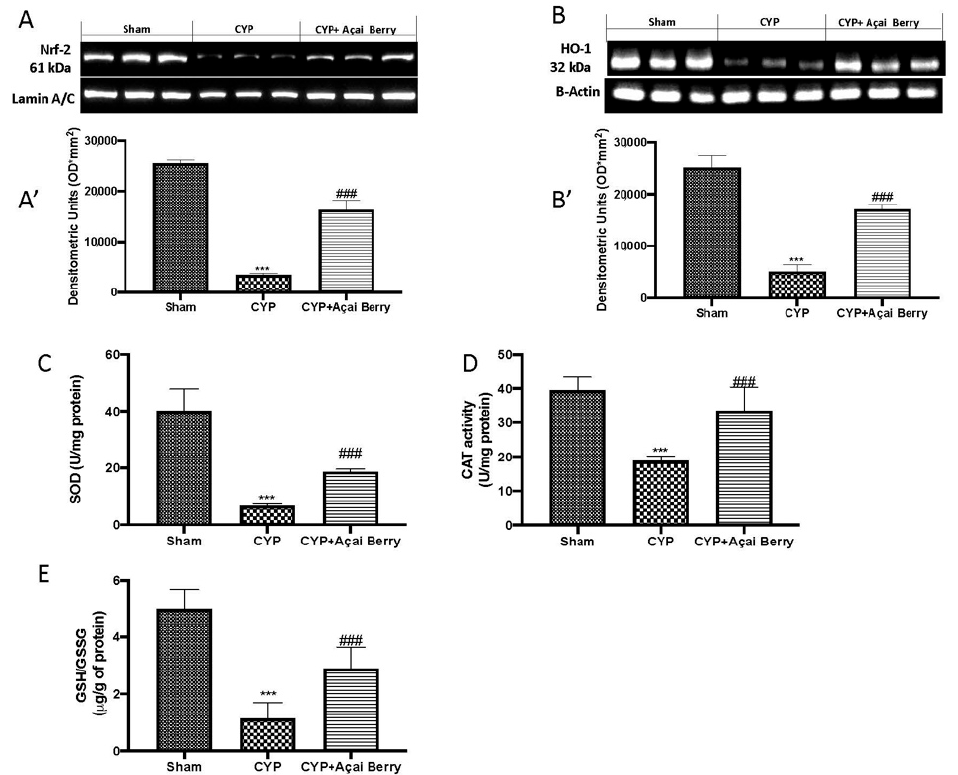
Figure 2. Effect of açai berry administration on CYP-induced bladder oxidative stress. ( A ) Western blot analysis and ( A’ ) densitometric analysis of Nrf-2; ( B ) Western blot analysis and ( B’ ) densitometric analysis of HO-1; ( C ) SOD; ( D ) CAT; ( E ) GSH/GSSG. *** p < 0.001 vs. sham; ### p < 0.001 vs. CYP.